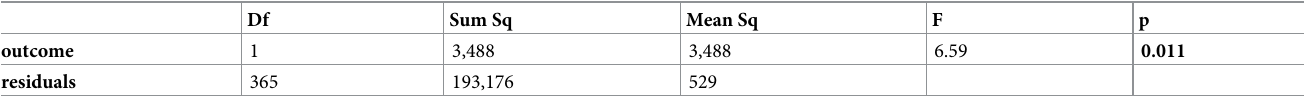
Table 3. One-way analysis of variance using immorality score as the criterion.